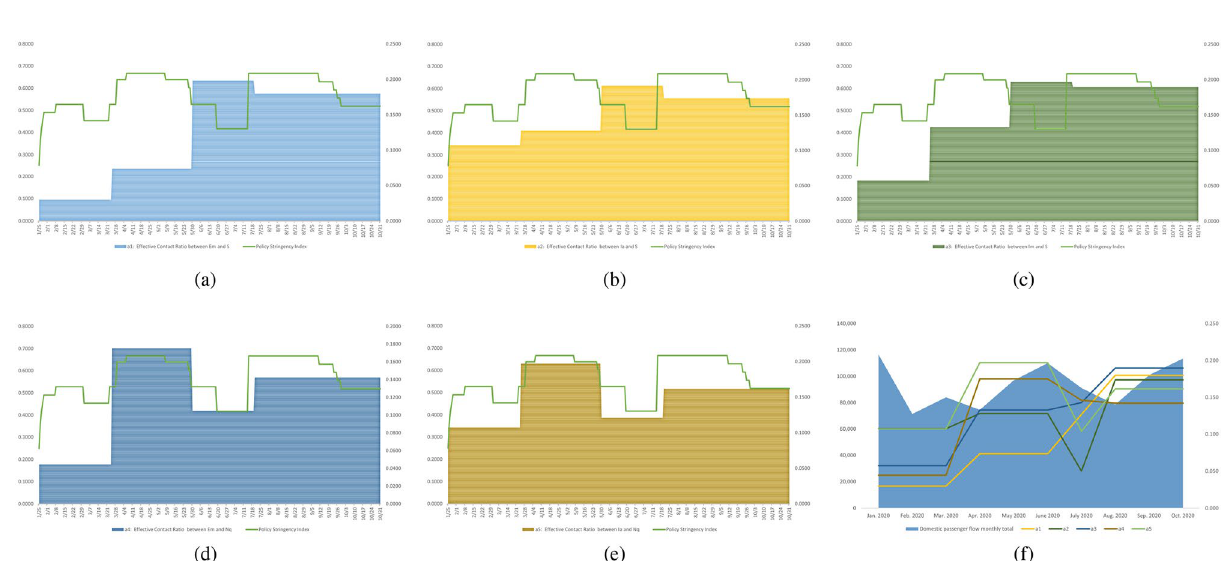
Figure 6. Comparison between policy stringency index scores and effective contact ratios from Jan. 25 to Oct. 31 in 2020: ( a ) a 1 effective contact ratio between E m and S , ( b ) a 2 effective contact ratio between I m and S , ( c ) a 3 effective contact ratio between I a and S , ( d ) a 4 effective contact ratio between E m and N q , ( e ) a 5 effective contact ratio between I m and N q and ( f ) comparison between domestic Mass Transit Railway (MTR) passengers flow and effective contact ratios 34